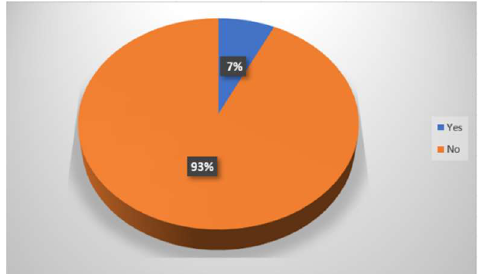
Figure 16. Answers to the second question of Unit A.